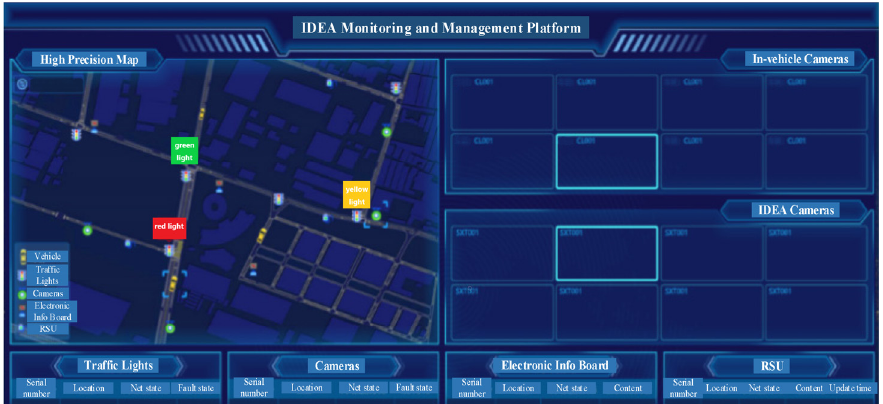
Figure 19. Monitoring